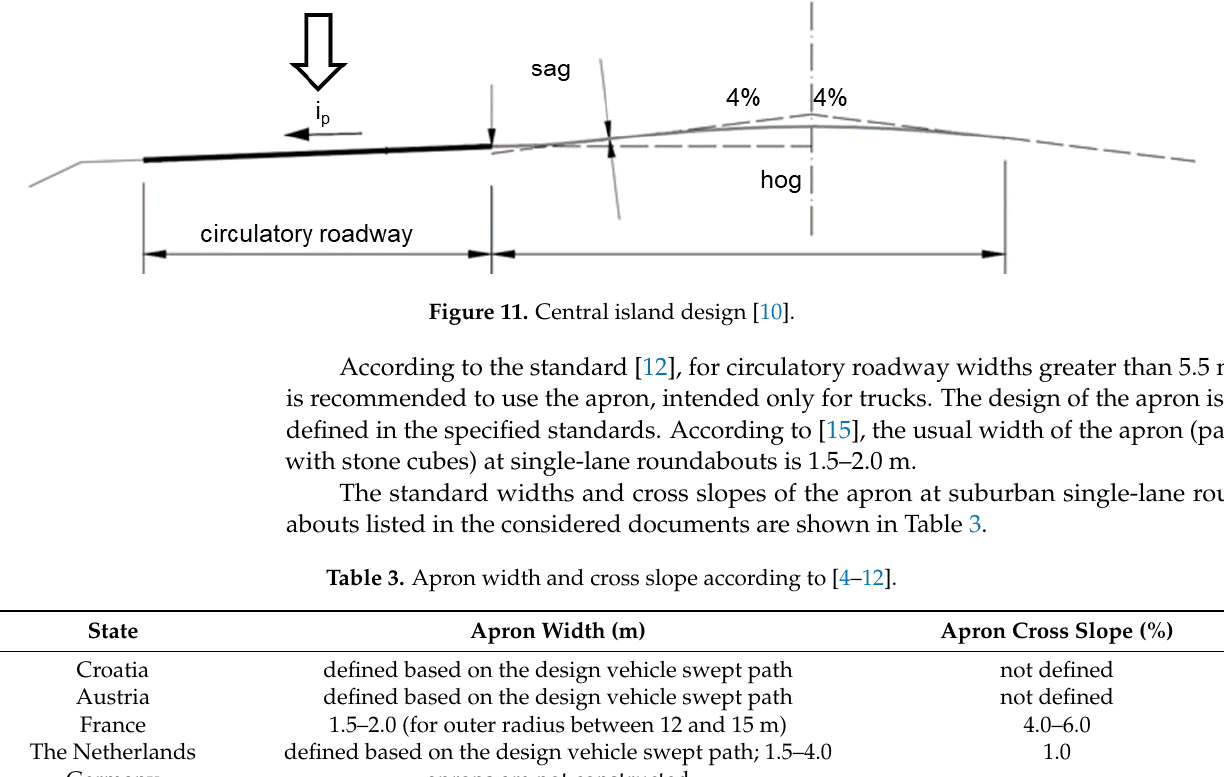
10 Figure 10. Standard circulatory roadway cross-section for roundabouts with an outer radius of 15 m, according to [6]. According to [7,8], the apron width depends on the design vehicle and the combination of dimensions of the remaining geometric elements of the roundabout. The standard cross slope of the apron is 1%. The apron is constructed with a low curb with a